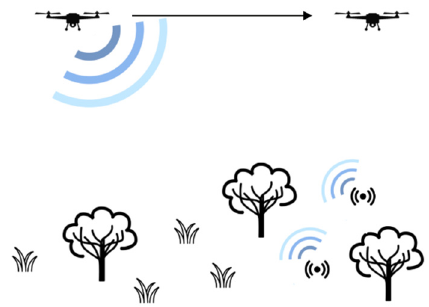
Figure 1. The structure of the UAV-assisted WSN.